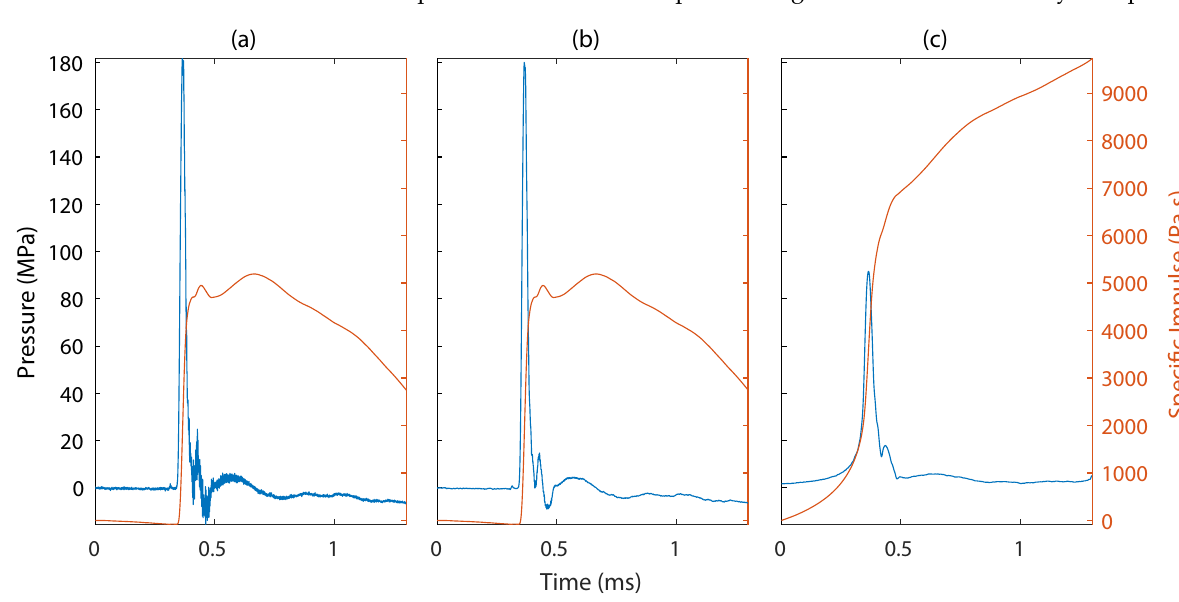
Figure 7. For a single HPB pressure trace: ( a ) Raw Signal vs. ( b ) Savitzky–Golay Filtered vs. ( c ) Inverse FFT Filtered. Blue = pressure, red = specific